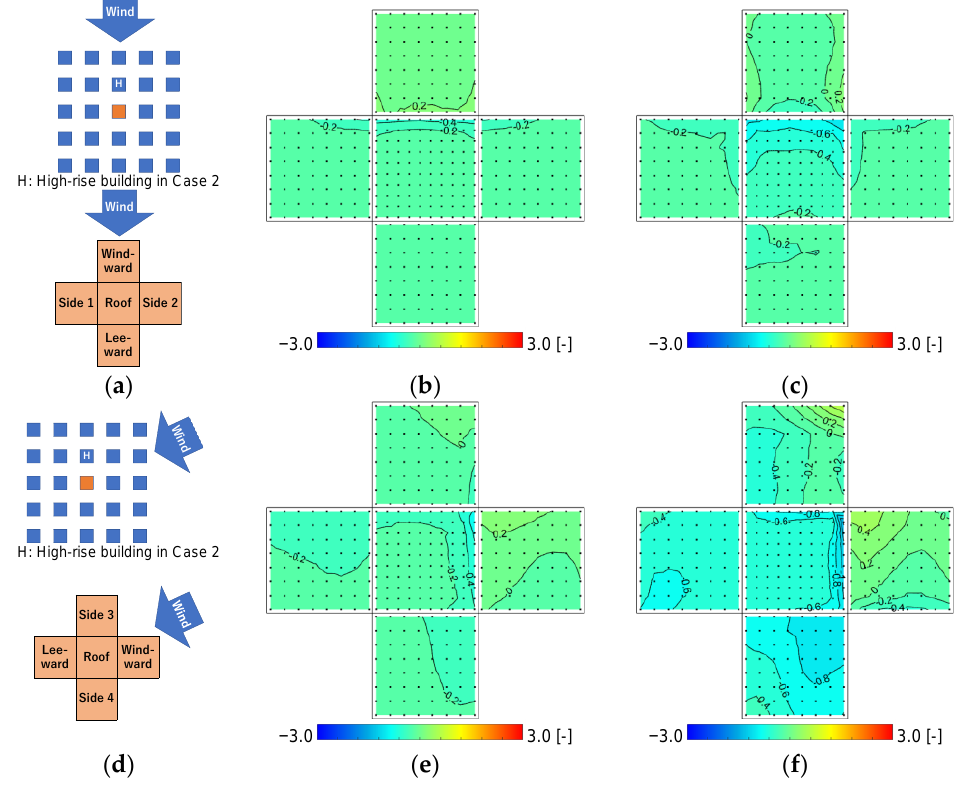
Figure 12. Mean wind pressure coefficient 𝐶 𝑝 ̅̅̅ ; ( a ) building model arrangement and prevailing wind direction for ( b , c ); ( b ) wind direction of 0° in Case 0 with no high-rise building; ( c ) wind direction of 0° in Case 2 with a high-rise building next to the pressure measurement model; ( d ) building model arrangement and prevailing wind direction for ( e , f ); ( e ) wind direction of 65° in Case 0; ( f ) wind direction of 65° in Case 2.